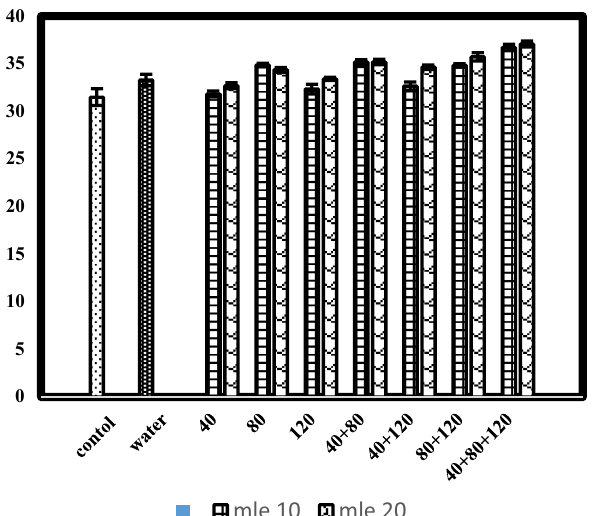
Figure 2. Fixed oil content (%) of black cumin as affected by moringa leaf extract applied at various growth